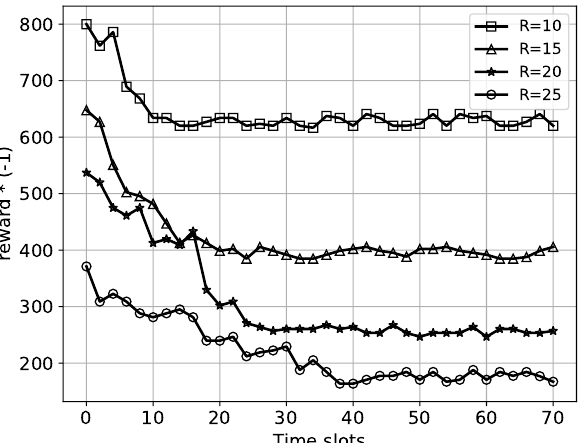
Figure 4. Convergence of the proposed ACRS under different resource conditions.